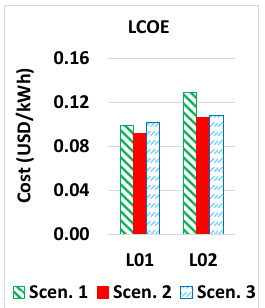
Figure 17. Levelized cost of electricity for the scenarios and the two load types.